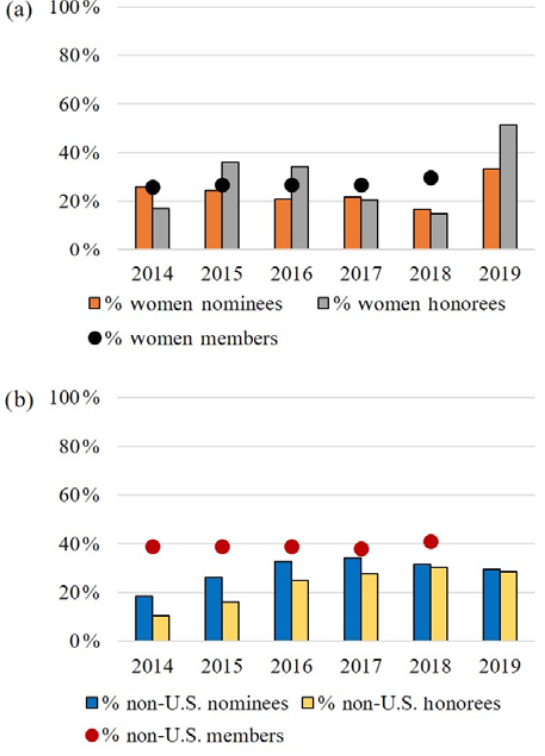
Figure 1. Percentage of women (a) and non-US members (b) for AGU membership (circles), nominees and honourees (bars) for all twenty-six Union-level awards, medals and prizes of women mem-